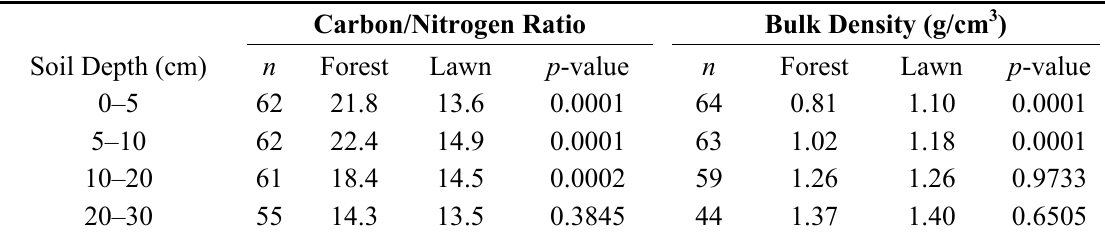
Table 2. Average carbon-nitrogen ratio and bulk density measured at four soil depths in mixed oak forests and adjacent residential lawns in the Valley and Ridge physiographic province of southwest Virginia. Lower sample size with greater soil depth is due to encountering bedrock or buried stones with core sampler at